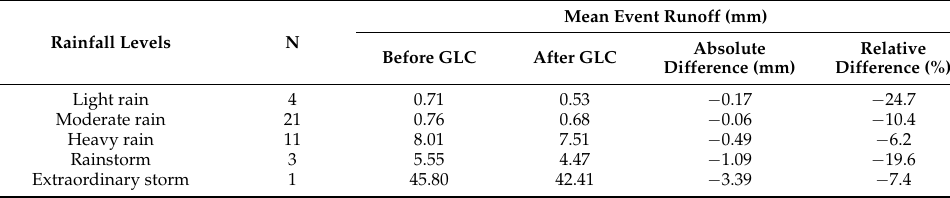
Table 4. The mean event surface runoff before and after the implementation of GLC. Rainfall Levels